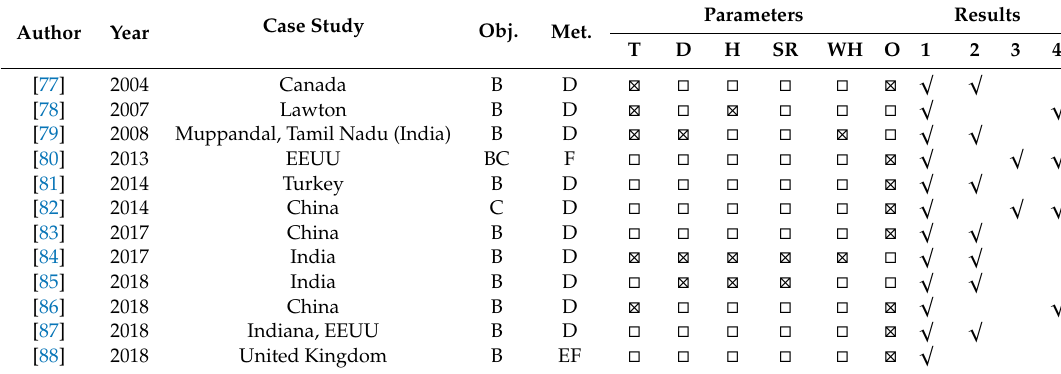
Table 3. Reviewed ANN studies on Wind